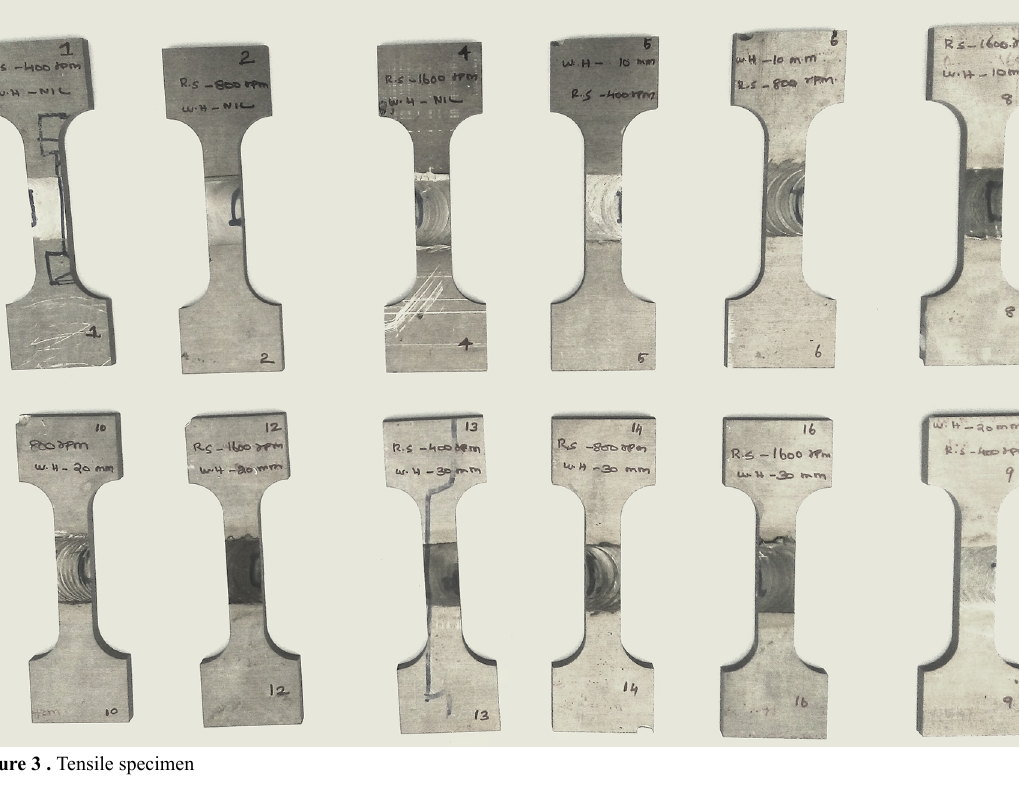
Figure 3 . Tensile specimen